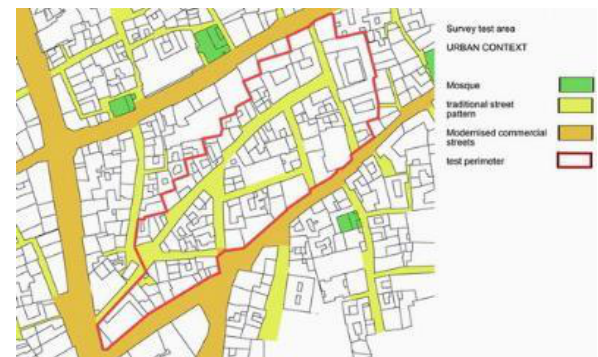
Figure 4. A portion of Manama city, old district 2006, showing more focus the urban fabric and spaces usage in old district (Agriculture, 2007)